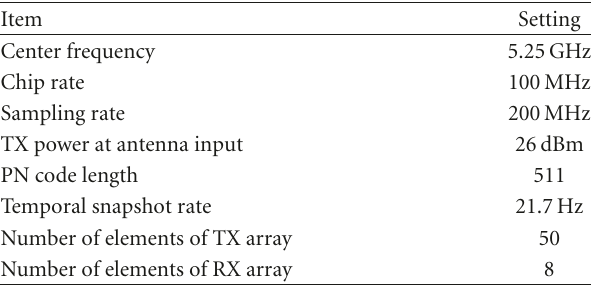
Figure 3: Configurations of the antenna arrays used in the measurements. Table 2: General sounder